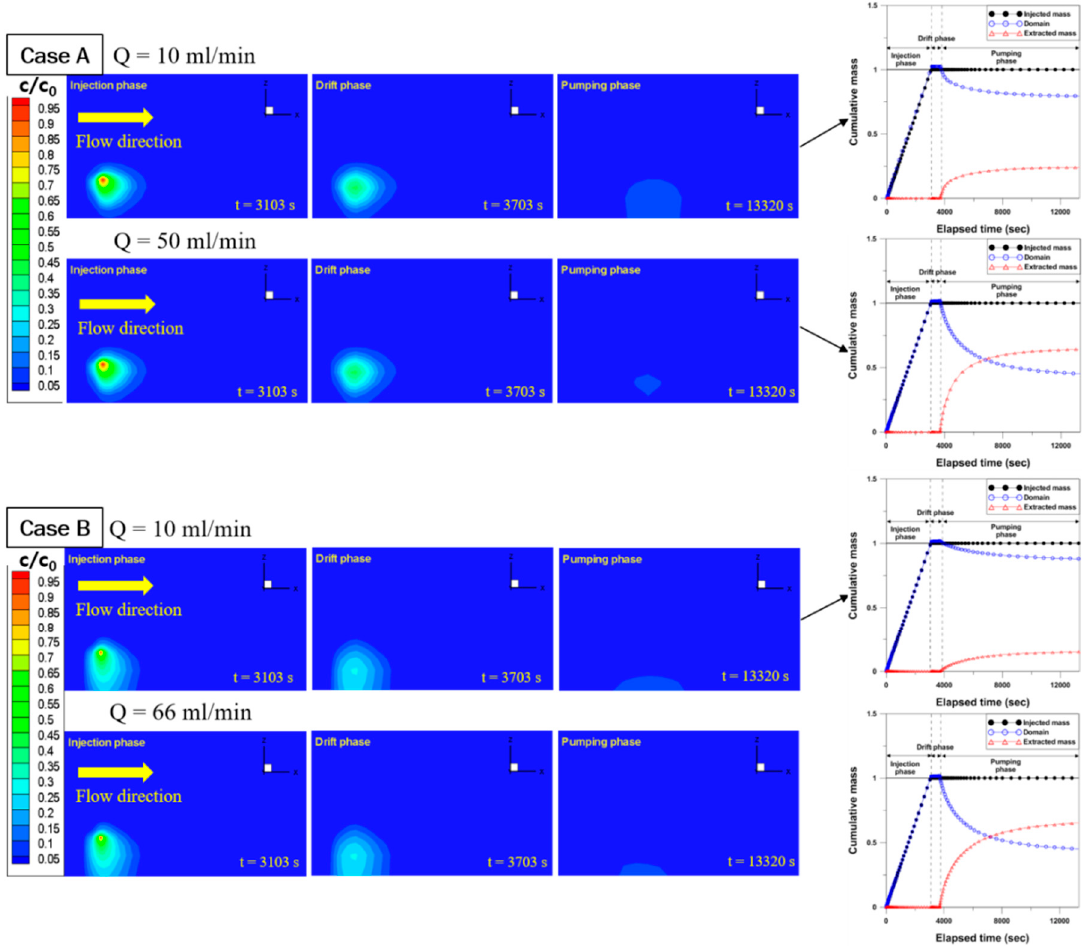
Figure 9. Numerical simulation results in the no-density effect condition (case ( A ), 160 mg/L) and the density-effect condition (case ( B ), 500 mg/L) at three time points (t = 3103 s: the end of the injection phase, t = 3703 s: the end of the drift phase, and t = 13,320 s: the end of the pumping phase) with different pumping rates.